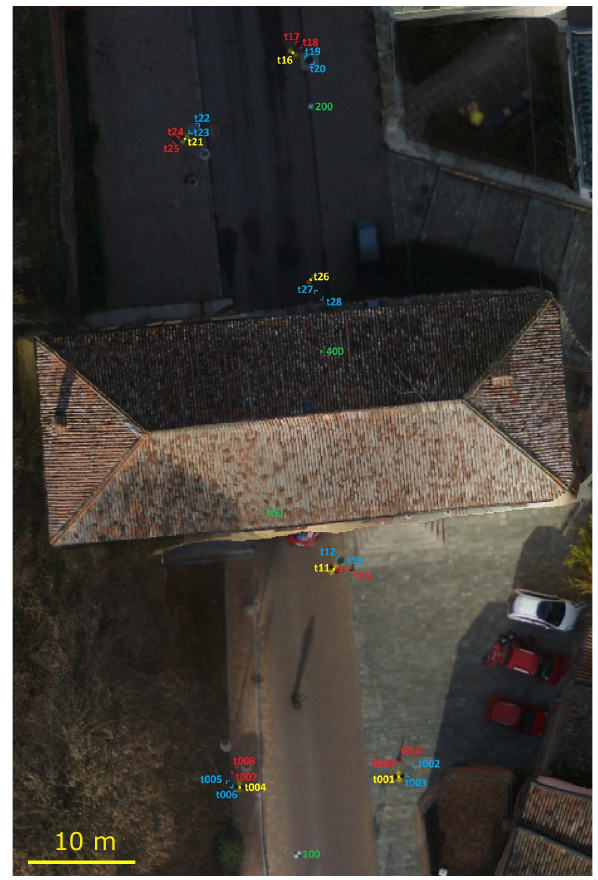
Figure 2. Points acquired. Station points (green), high-contrast signals (yellow), road cones (red), manholes covers (blue)